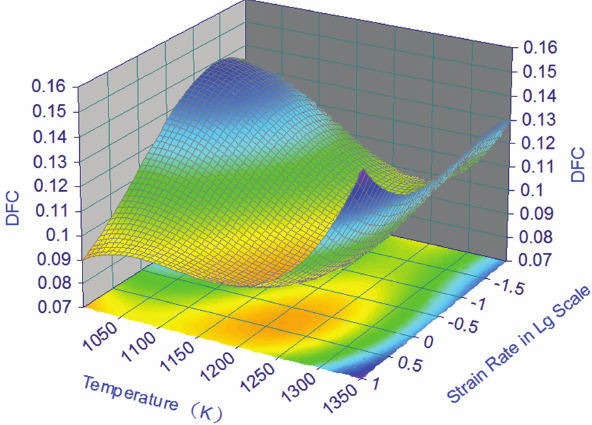
Figure 8: The response surface of the ductile fracture criteria of Ti- 6Al-4V alloy in temperature and strain